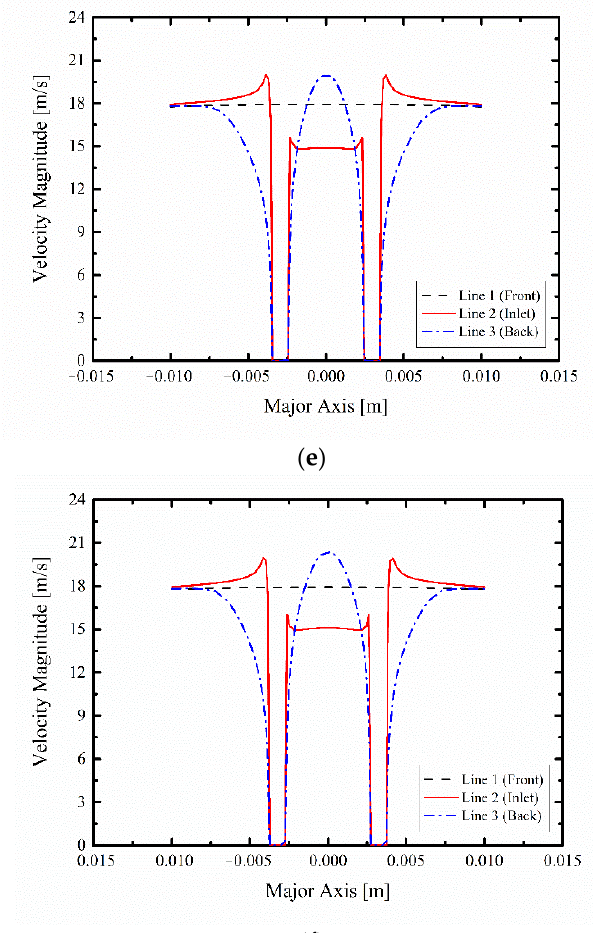
Figure 8. Velocity distribution around the sampling probe according to free-stream velocity: ( a ) 5 m/s free-stream, circular inlet; ( b ) 5 m/s free-stream, ellipsoidal inlet; ( c ) 10 m/s free-stream, circular inlet; ( d ) 10 m/s free-stream, ellipsoidal inlet; ( e ) 15 m/s free-stream, circular inlet; and ( f ) 15 m/s free-stream, ellipsoidal inlet.